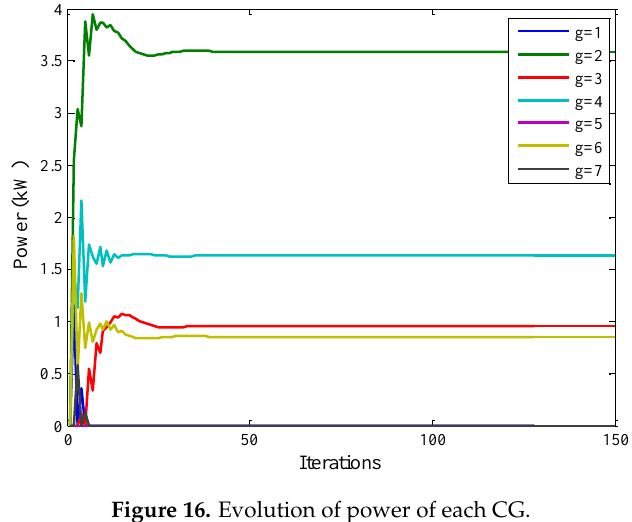
Figure 16. Evolution of power of each CG.